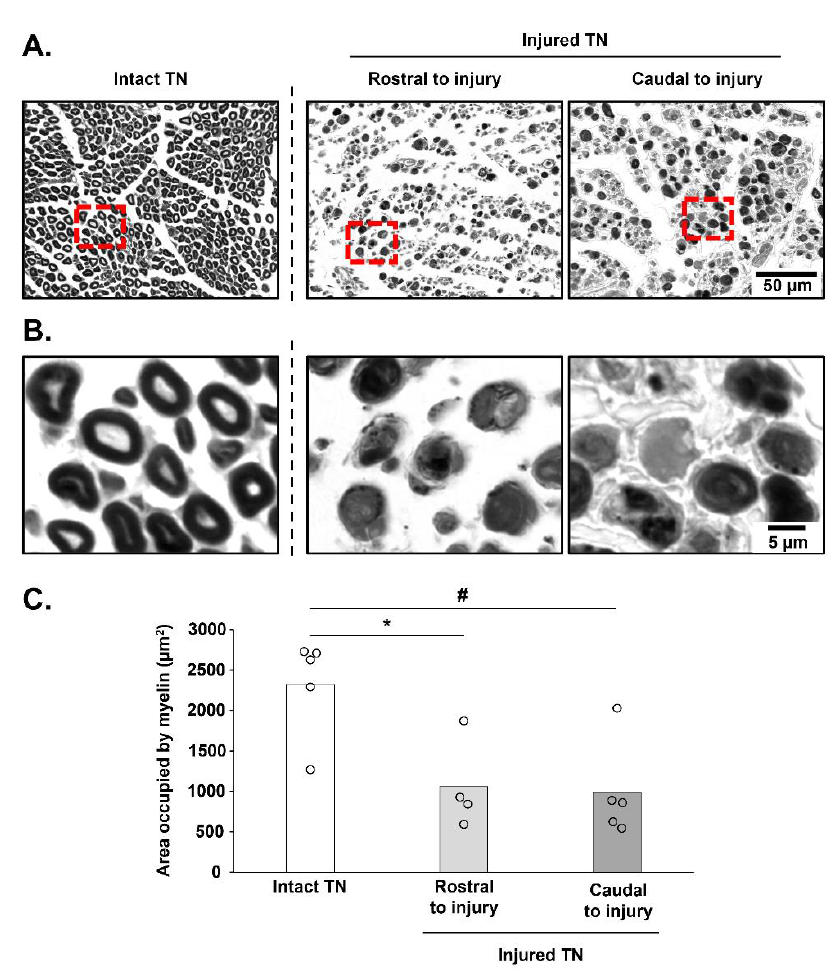
Figure 5. Histological confirmation of tibial nerve crush: ( A ) Representative caption of tibial nerve (TN) cross sections, 7 days post-crush for the intact (right) TN nerve and for the crushed TN, rostral and caudal to injury. ( B ) Magnification of TN cross sections showed in A. Red dot lines represent the magnified areas. ( C ) Quantification of surface occupied by myelin in TN cross sections. * p < 0.05 compared to Intact TN; # p < 0.05 compared to Caudal to injury.